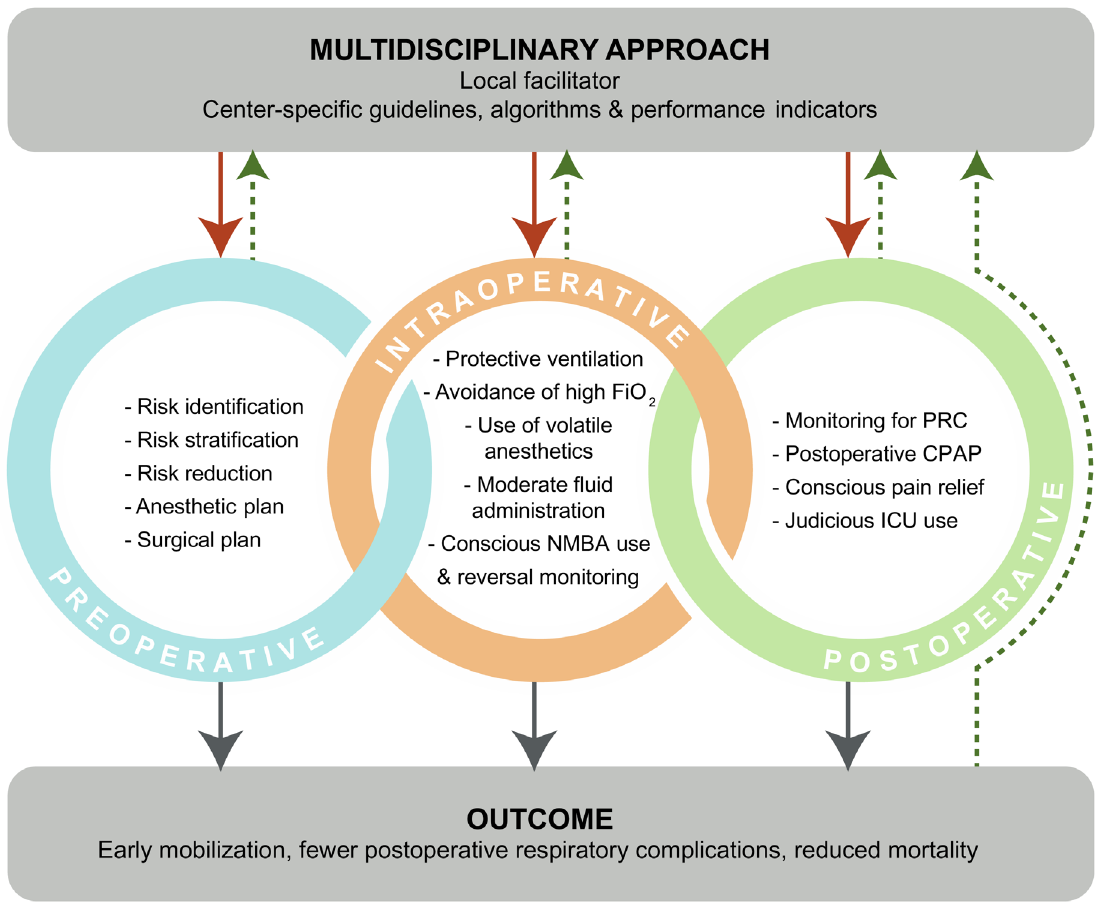
Figure 2. Integration of multilevel guidelines for the prevention of postoperative respiratory complications (PRCs). In a multidisciplinary approach, center-specific guidelines, algorithms, and performance indicators should be developed. Their implementation (red solid arrows) can be facilitated by a local “champion”. Factors concerning the preoperative, intraoperative, and postoperative period need to be addressed, as each can have an impact on outcomes. Periodic review and assessment of processes and outcomes (green dotted arrows) will ensure continuous improvement. CPAP, continuous positive airway pressure; FiO2, fraction of inspired oxygen; ICU, intensive care unit; NMBA, neuromuscular blocking